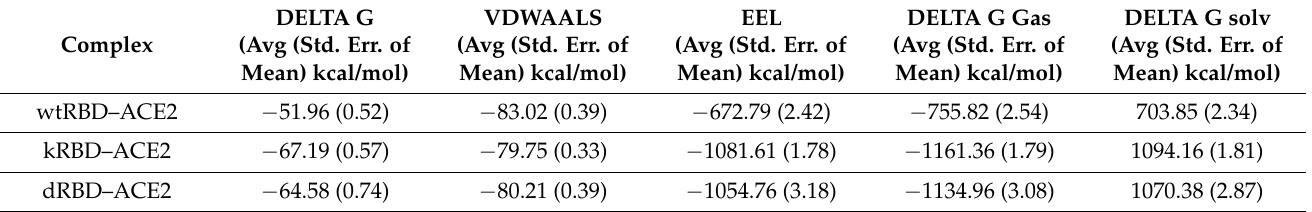
Table 1. The binding free energy components for the wtRBD, kRBD, and dRBD in complex with the ACE2.